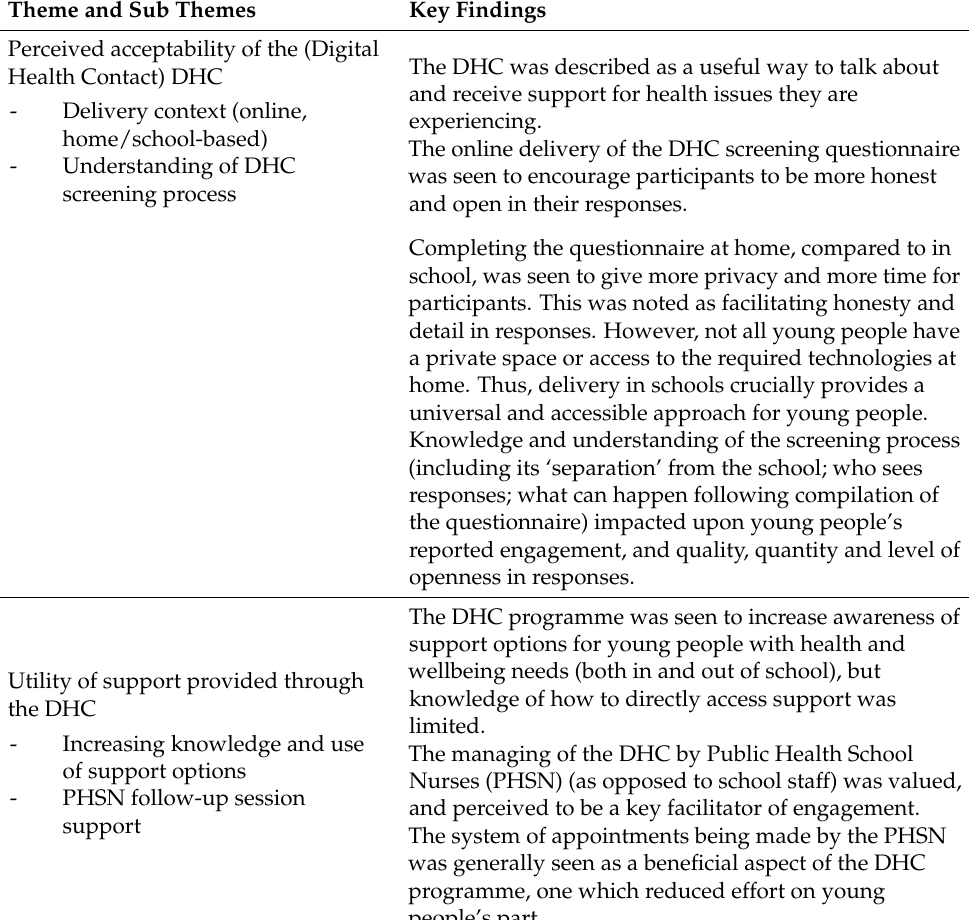
Table 2. Summary of key findings. Theme and Sub Themes Key